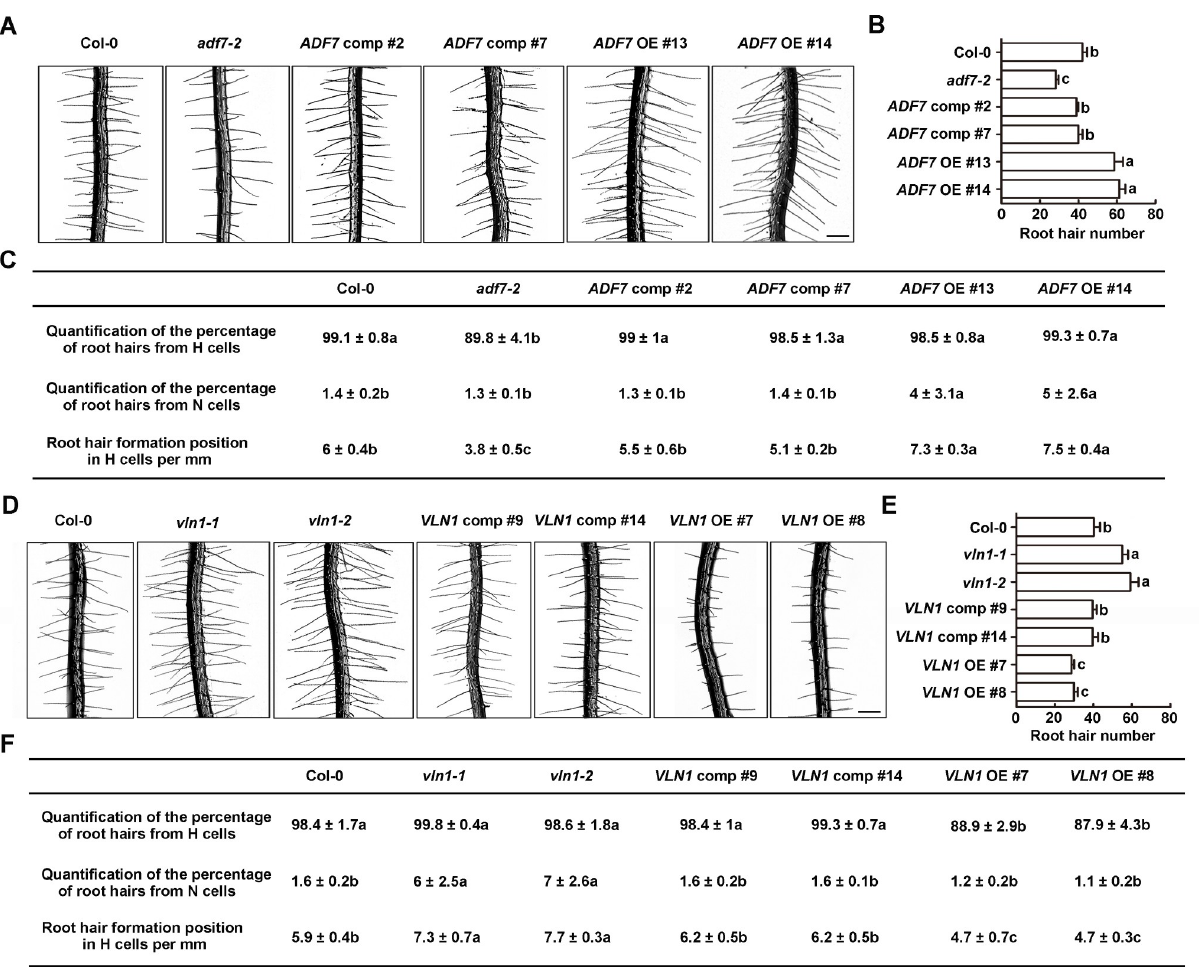
Fig 1. Actin depolymerization protein ADF7 is positively involved in root hair formation and actin bunding protein VLN1 is negatively involved in root hair formation. (A) Images of root hairs from wild type (Col-0), adf7-2 , ADF7 comp #2, ADF7 comp #7, ADF7 OE #13, and ADF7 OE #14. Scale bar, 200 μ m. OE, overexpression. (B) Histogram depicting root hair number in (A) . (C) Quantification of the percentage of root hairs from H and N cells and root hair formation position in H cells in (A) . Values given are means ± SD. (D) Images of root hairs from Col-0, vln1-1 , vln1-2 , VLN1 comp #9, VLN1 comp #14, VLN1 OE #7, and VLN1 OE #8. Scale bar, 200 μ m. (E) Histogram depicting root hair number in (D) . (F) Quantification of the percentage of root hairs from H and N cells and root hair formation position in H cells in (D) . Values given are means ± SD. Significant difference ( P < 0.05) indicated by different letters among genotypes is determined for each condition by one-way ANOVA followed by Tukey’s test in (B) , (C) , (E) , and (F)